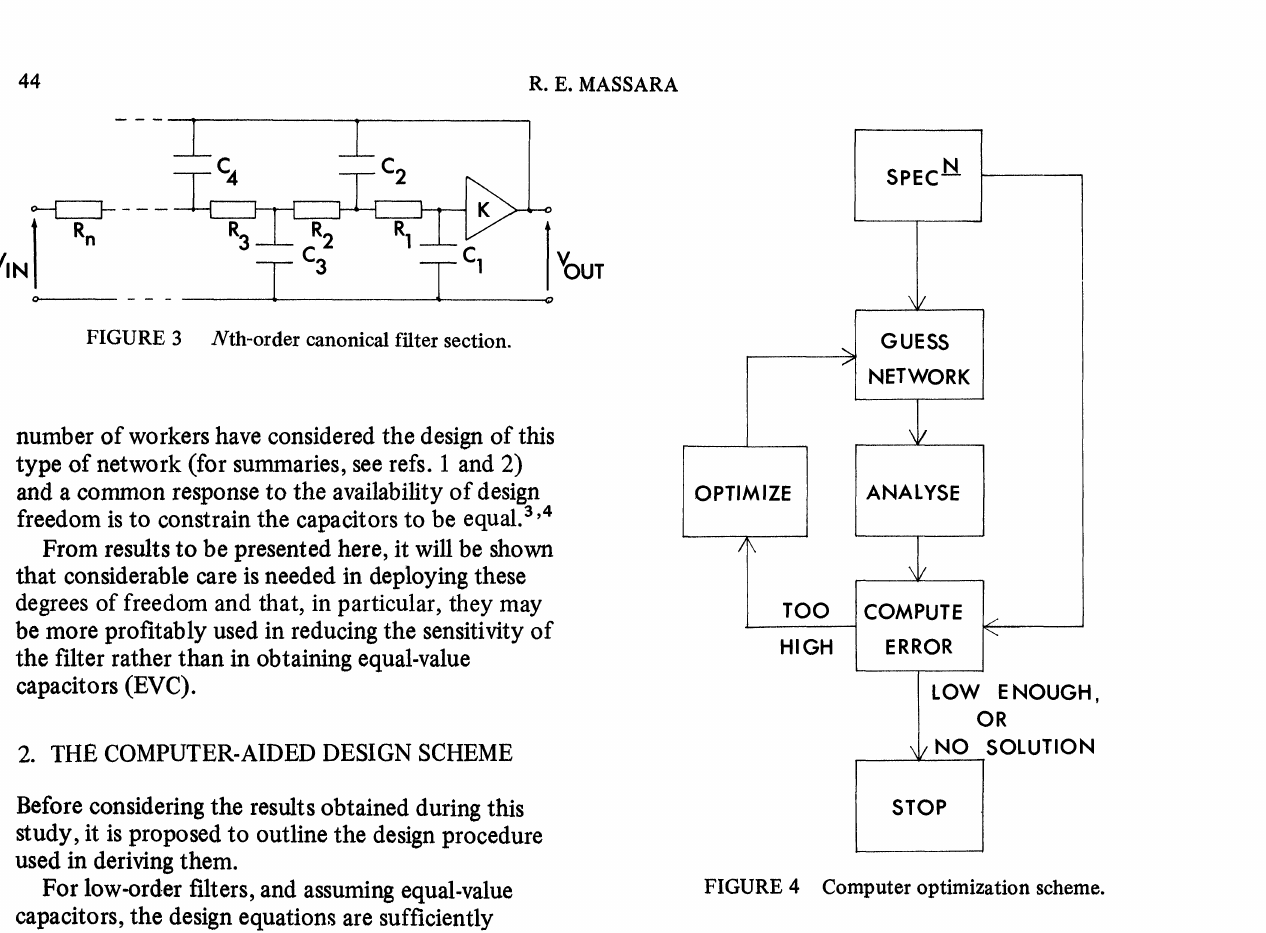
STOP FIGURE 4 Computer optimization